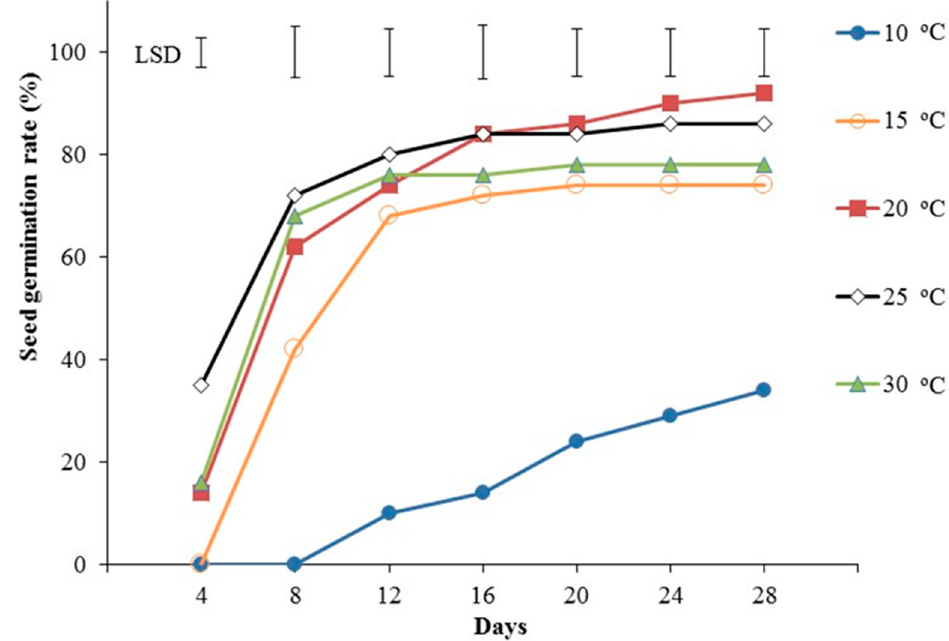
Figure 2. Effect of temperature (10 °C, 15 °C, 20 °C, 25 °C, and 30 °C) on Pancratium maritimum seed germination rate (%). Vertical bars = LSD ( p ≤ 0.05). Four replicates of 25 seeds per treatment.